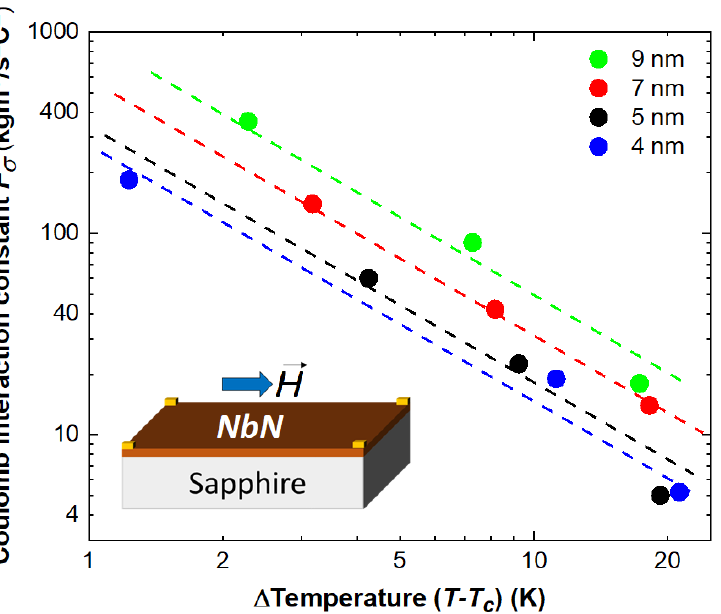
Figure 5. Temperature-dependent Coulomb interaction constant ( F σ ) extracted from modelling in-plane MR data (open symbols in Figure 4). Scattered lines in the figure are only guide for the